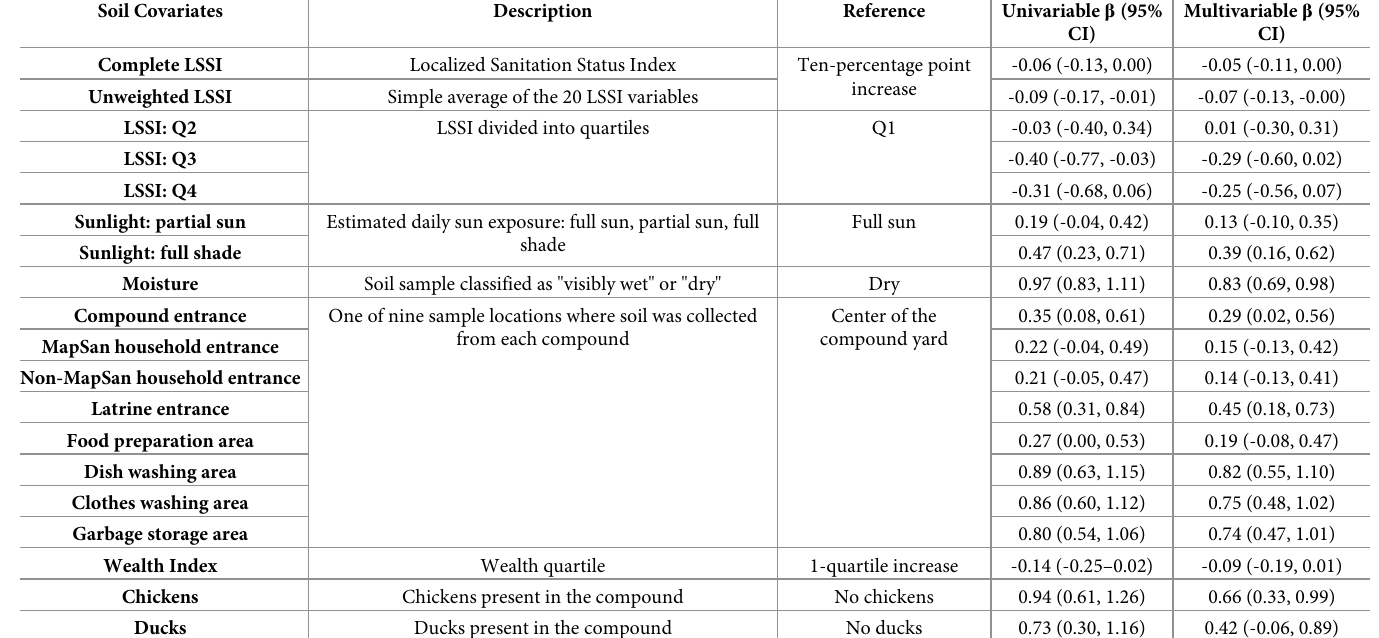
Table 3. Uni- and multi-variable regression models for log 10 -transformed E . coli concentrations in soil and adjusted for sunlight, intra-compound location, com- pound wealth, chickens and ducks. Soil